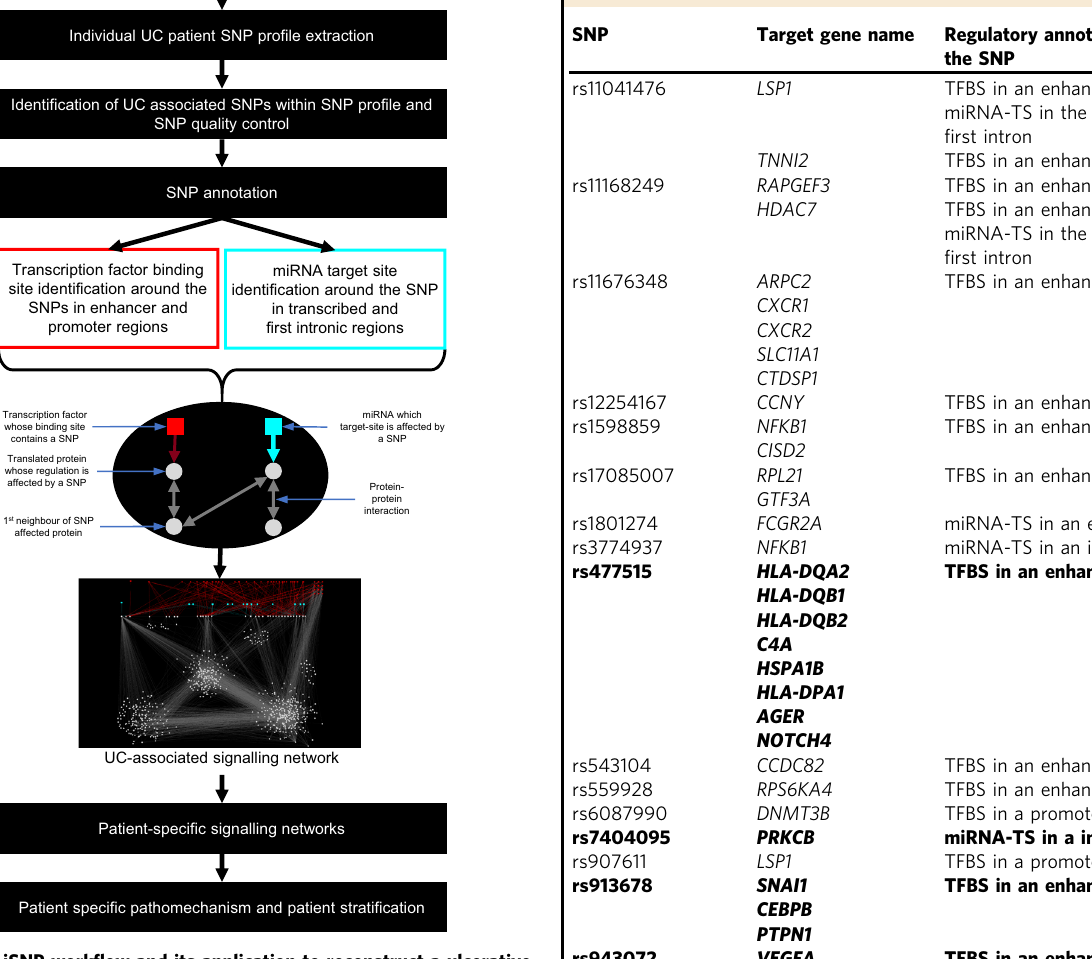
Table 1 Affected SNPs in the UC-associated signalling network, their target genes and interactions a